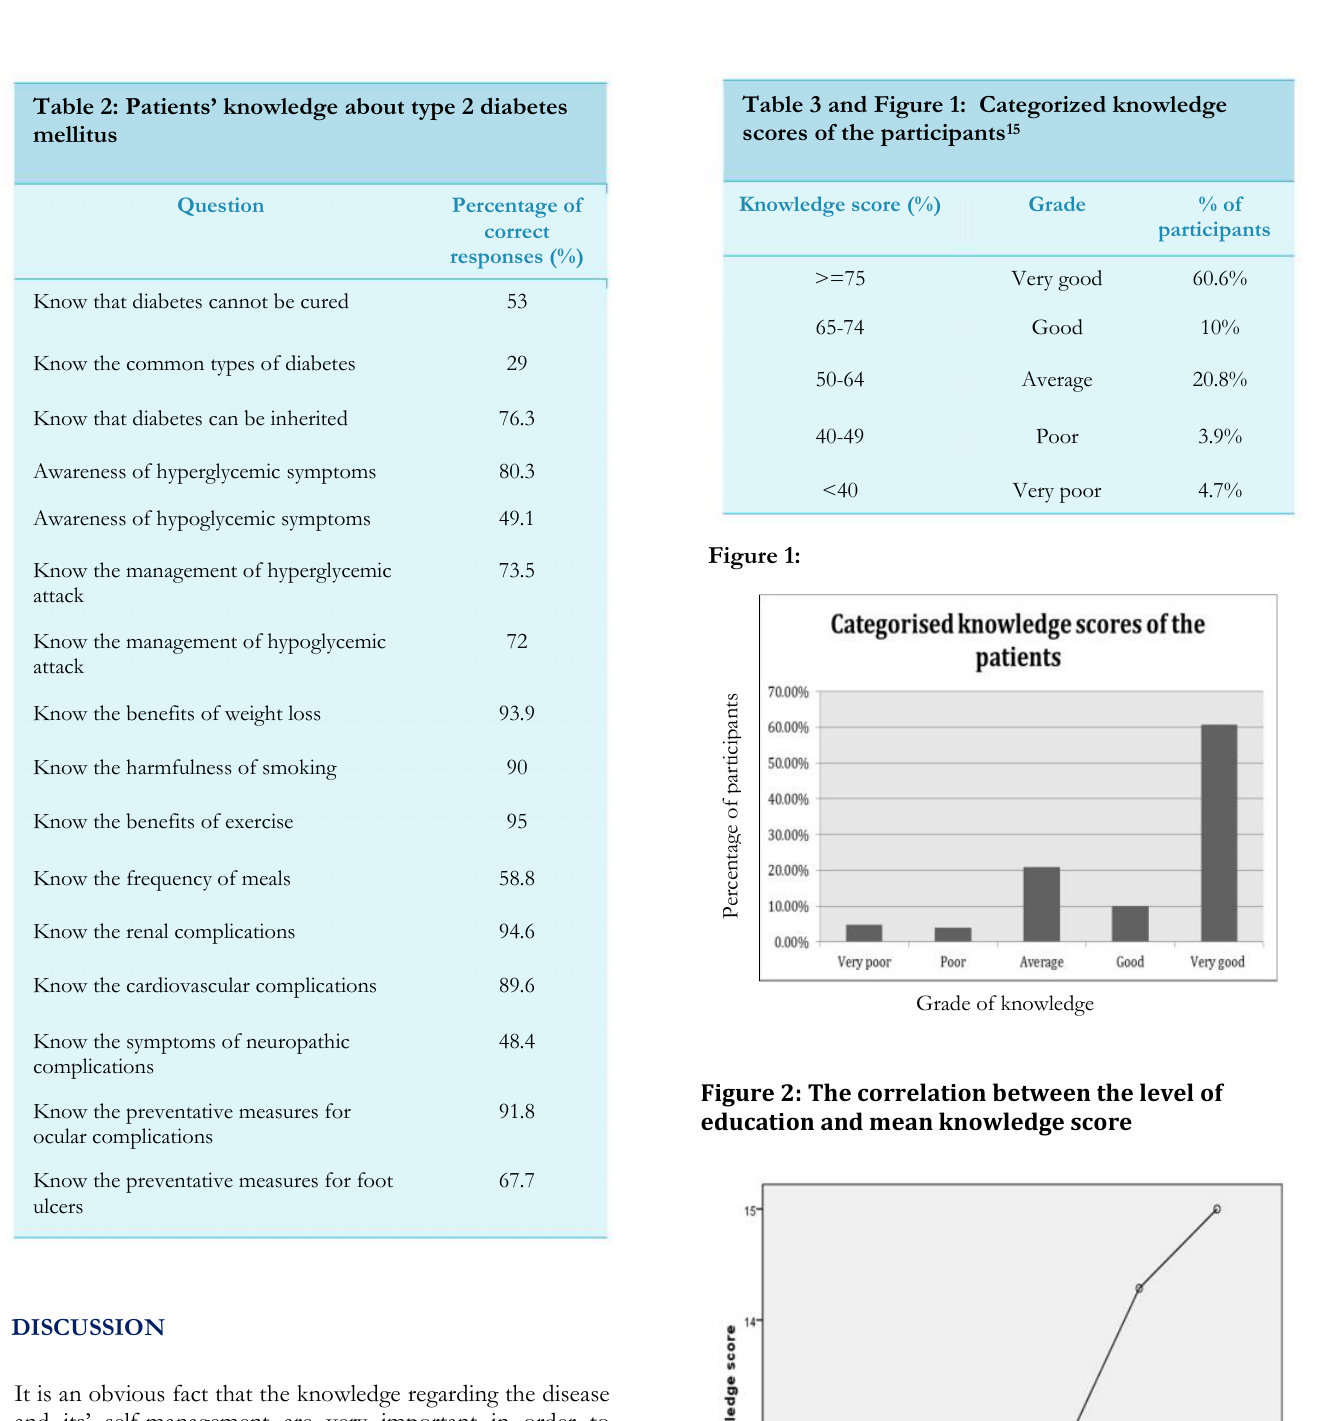
Table 2: Patients’ knowledge about type 2 diabetes mellitus